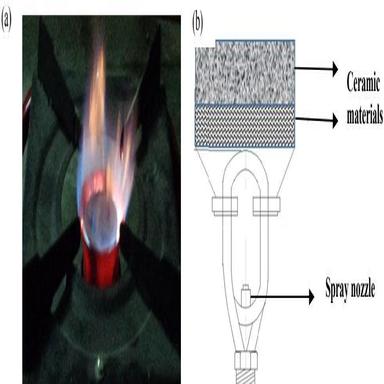
(a) Traditional burner; (b) Porous Burner